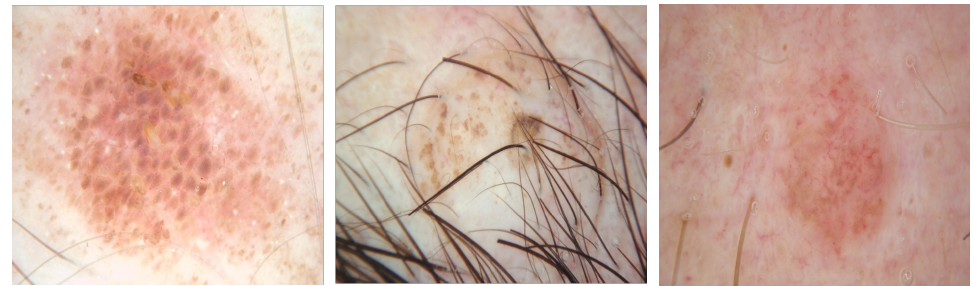
Figure 2. Uncertainty at the boundaries of the